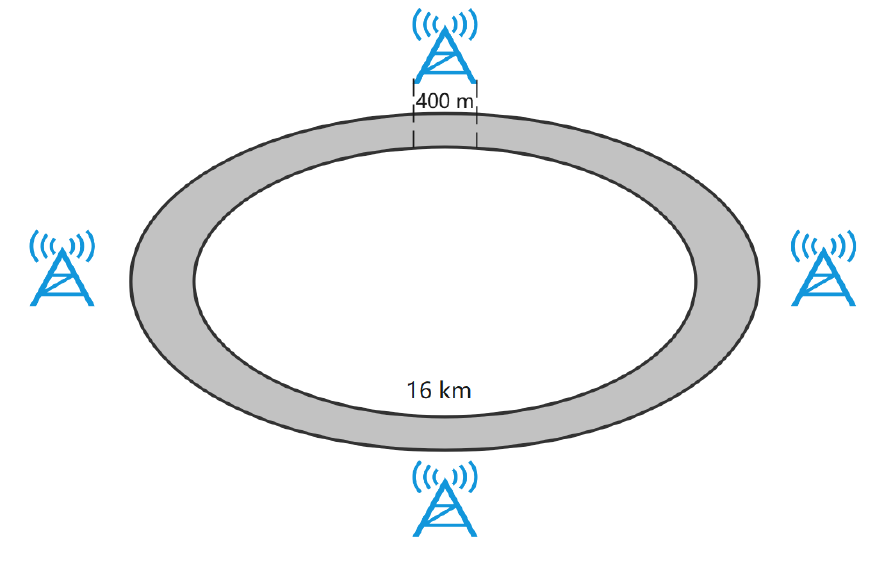
Figure 5. Vehicle movement